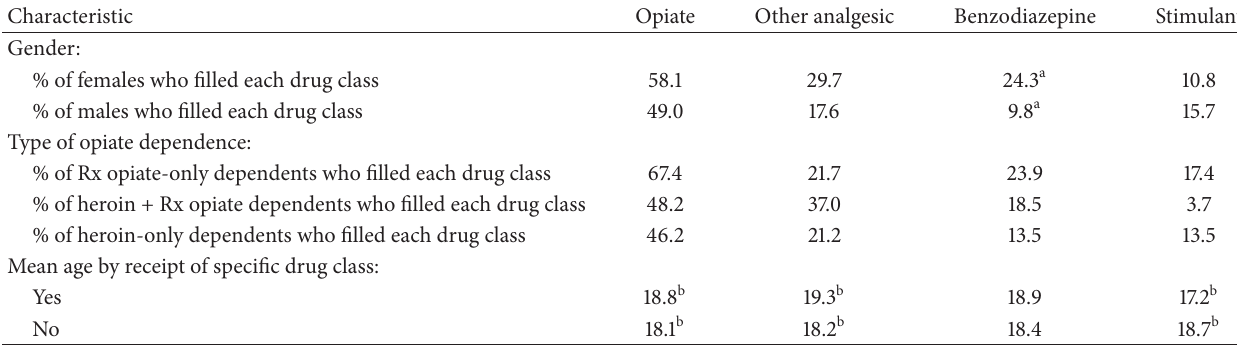
Table 2: Likelihood of filling prescriptions for specific drug classes by gender, type of opiate dependence, and age. Characteristic Opiate Other analgesic Benzodiazepine